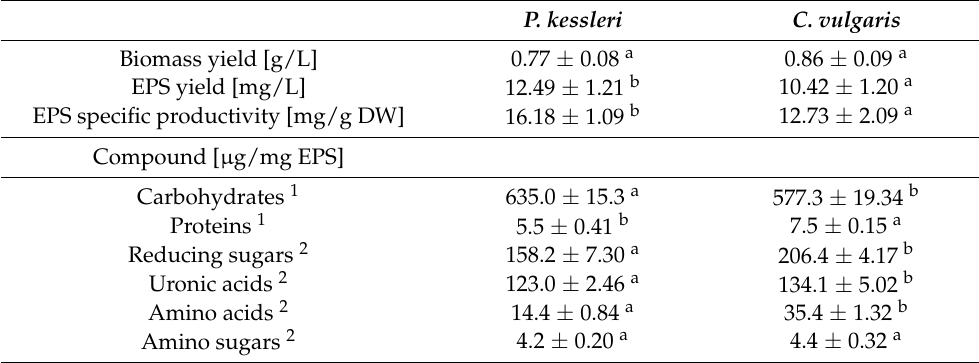
Table 1. The biomass yield and the productivity and biochemical composition of EPS synthesized by P. kessleri and C. vulgaris. The superscript letters (a, b) in the table indicate statistical significance of the presented results analyzed by ANOVA Tukey’s test ( p ≥ 0.05) (EPS = 1 mg/mL; n = 3; ±